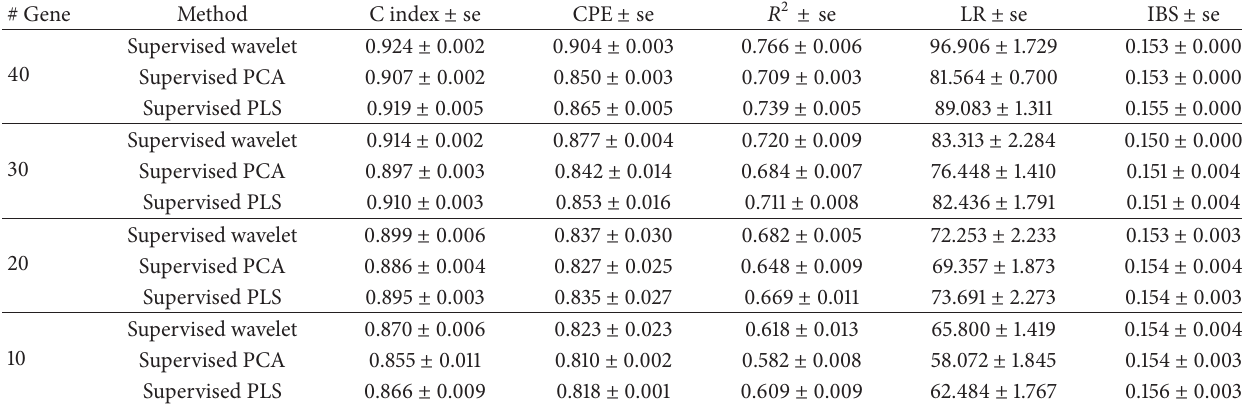
−0.2−0.1 Figure 4: Box plot of the difference in model evaluation criteria between the supervised wavelet and the two other methods for Lung dataset with different number of preselected genes. Table 1: Performance of different Cox models for simulated